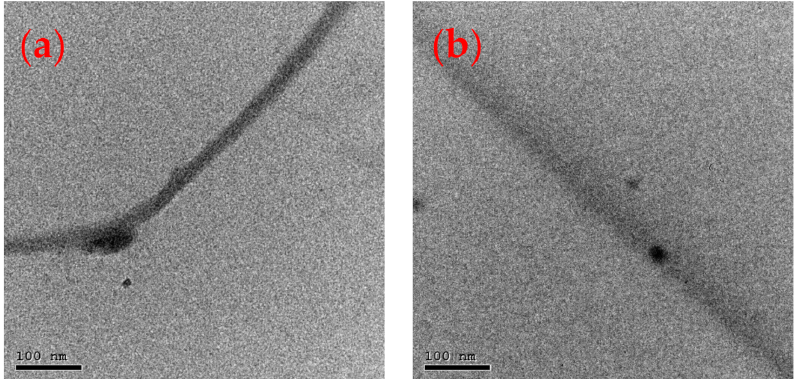
Figure 5. ( a , b ) Transmission Electron Microscopy (TEM) micrographs of nanofibrous scaffolds of PCL containing HAP doped with co-ions (Ag/V): ( a ) 0.4 Ag/V-HAP@PCL, ( b ) 0.8